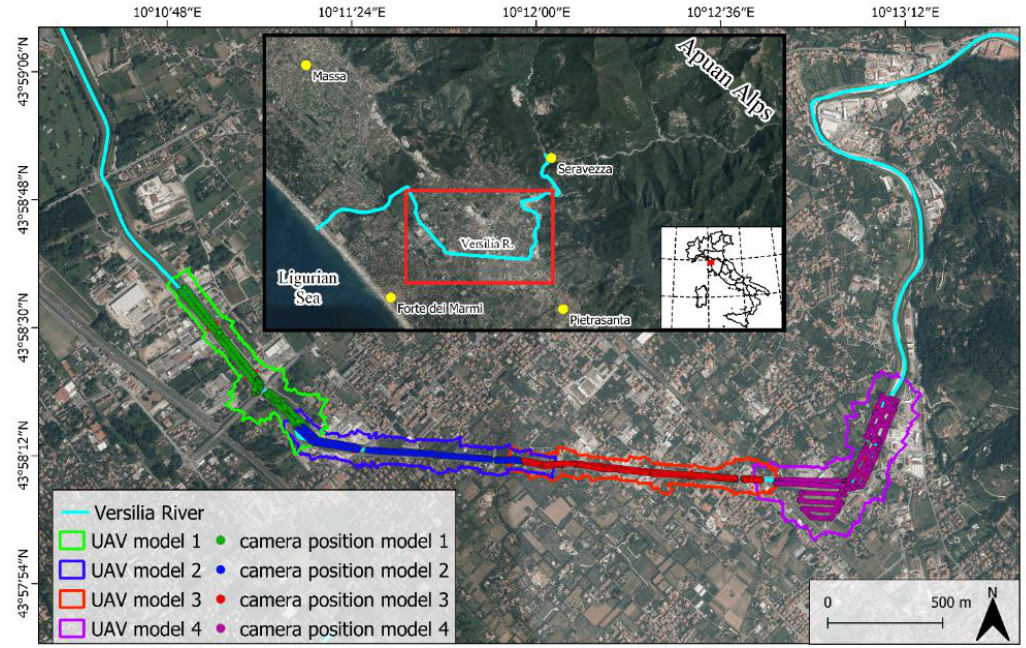
Figure 1. Study area showing the extent of the four DEMs derived from UAV surveys.